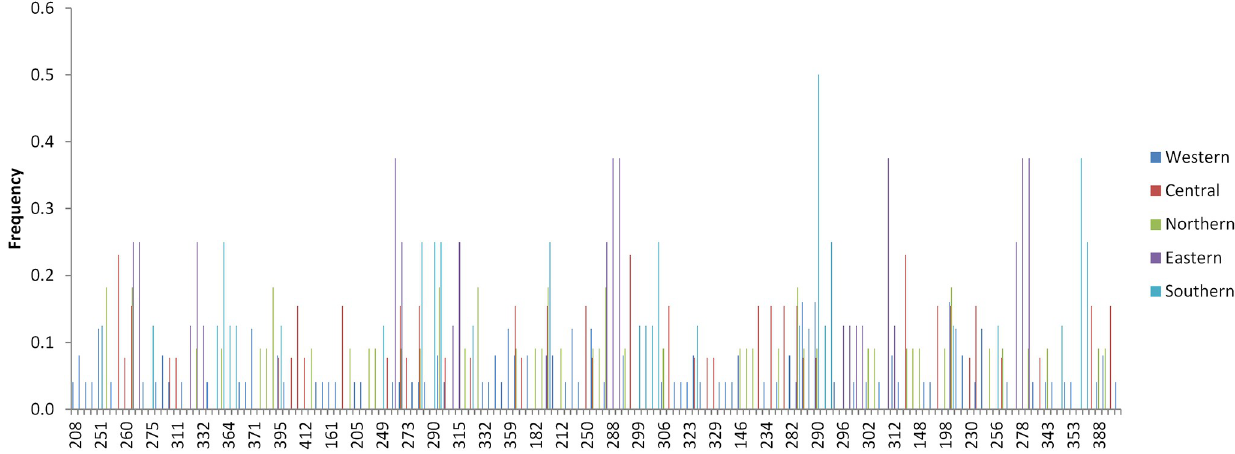
Fig 7. Overall frequency of alleles from Burundi field samples without the Muguga cocktail and Chitongo vaccine stocks. Both shared and unique alleles are present and the predominant alleles were calculated as proportions of the total of each satellite marker. The histograms were generated from the multi-locus